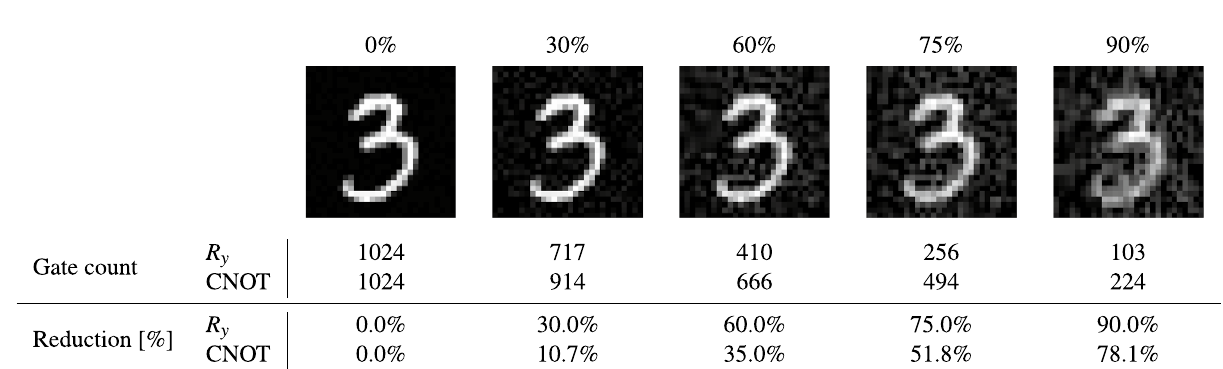
28 image data from the MNIST 47,48 database simulated with Figure 5. 28 × levels and corresponding gate counts of the 11-qubit U R circuit. The final two rows list the reduction in R y and CNOT gates compared to the uncompressed